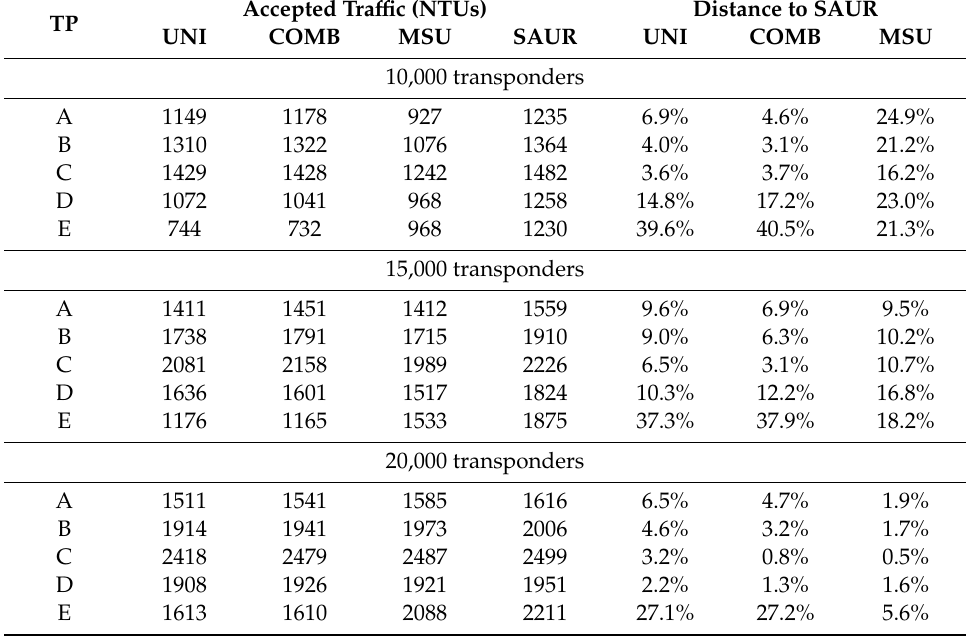
Table4. Comparisonofalgorithmsforvariousnumberoftranspondersandtra ffi cprofiles, US26network in terms of the accepted tra ffi c expressed in NTUs (network tra ffi c units).